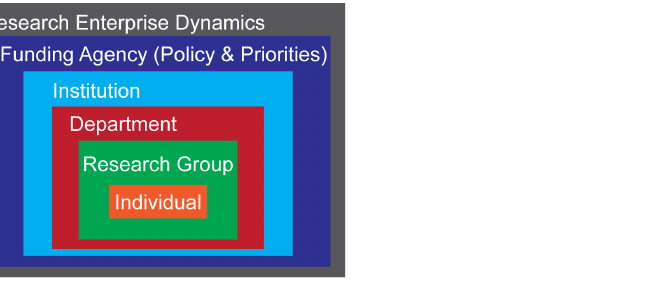
Fig. 3. Ecological Conceptualization of Factors Impacting Career Development of Biomedical Scientists. As disparities in career interest at Ph.D. completion by social identity persist when controlling for productivity, self-efficacy, advisor interactions, and other determinants of career choice, we propose that workforce development and diversity efforts utilize an ecological framework that takes into account the multiple agents that can influence the career decision-making process. These include individual level variation, research group and advisor, department and institutional training environment, pressures exerted by funding agencies, and the broader dynamics in the research